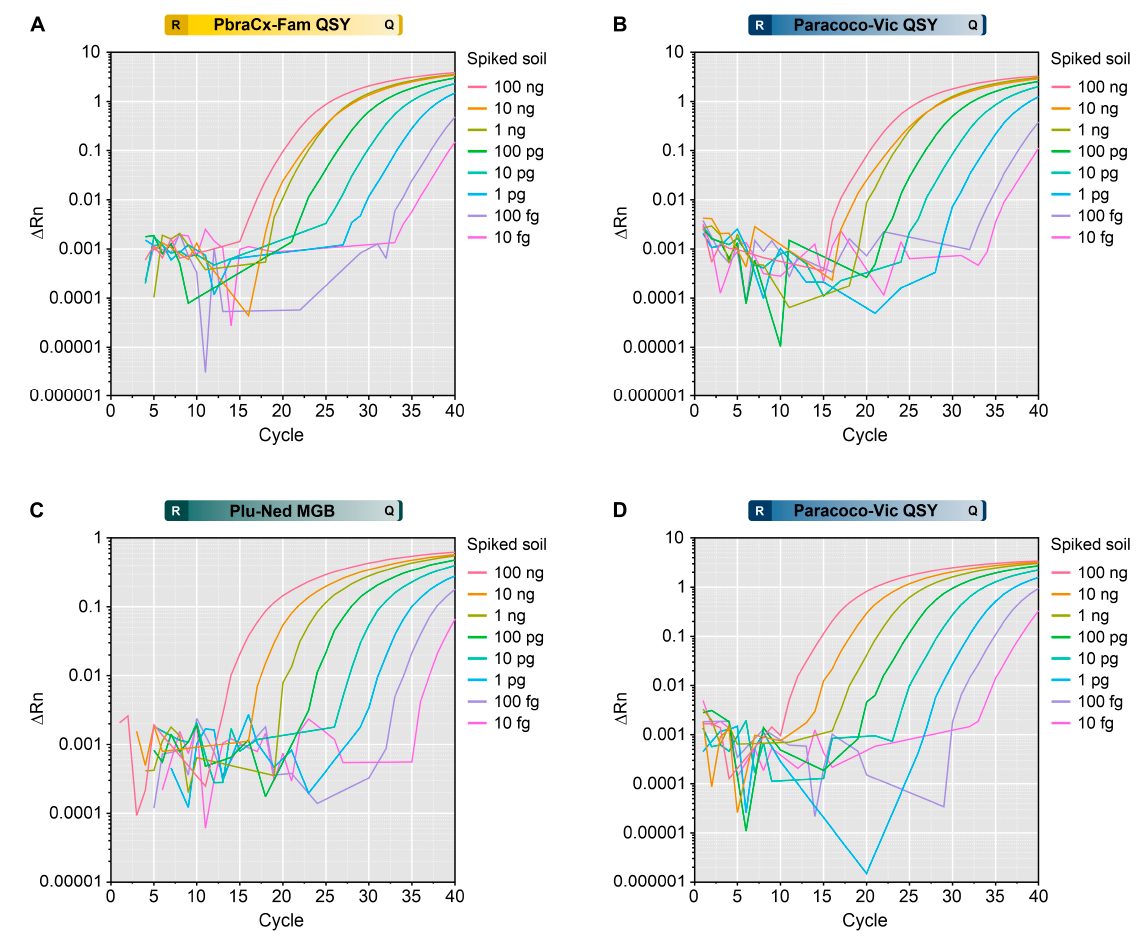
Figure 7. Assessment of a triplex-probe qPCR to detect ( A , B ) P. brasiliensis or ( C , D ) P. lutzii DNA in the spiked soil. The amplification plot for the PbraCx-Fam probe ( A ) or Paracoco-Vic probe ( B ) and the DNA from Pb18. The amplification plot for the Plu-Ned probe ( C ) or Paracoco-Vic probe ( D ) and the DNA from Pb01. Different colors of amplification curves represent samples from soil spiked with different inputs of Paracoccidioides DNA (100 ng–10 fg). ∆ Rn relates to the magnitude of the normalized reporter value (fluorescence signal) used to construct the standard curve. The results are typical of two separate experiments. R: reporter; Q: quencher.